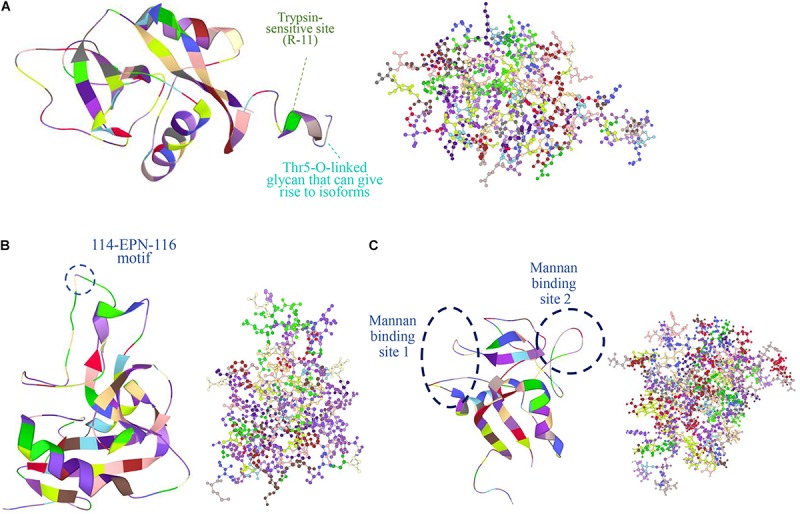
Protein structures obtained from the Protein Data Bank (PDB: https://www.rcsb.org/) are shown in figures of ribbon and ball and stick (colored by residues) of the human (A) REG1A (PDB ID: 1QDD, Gerbaud et al., 2000), (B) REG3A (PDB ID: 4MTH, Mukherjee et al., 2014), and (C) REG4 (PDB ID: 2KV3, Ho et al., 2010). In REG1A, the signal peptide is 22-aa long shortening the protein chain from 166 to 144 aa with a trypsin-sensitive arginine at position 11 (R-11) (De Reggi and Gharib, 2001). A Thr5-O-linked glycan is also featured that gives rise to different isoforms (De Reggi et al., 1995). REG3A (HIP/PAP) recognizes peptidoglycan carbohydrate backbones through an 114-EPN-116 motif that confers bactericidal activity while a E114Q mutation weakens this interaction (Lehotzky et al., 2010). REG4 has a C-type like domain (CTLD) and two calcium-independent sites that bind mannan (Ho et al., 2010). Images were created in LiteMol Suite (Sehnal et al., 2017).